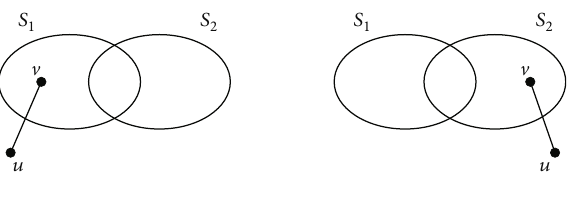
Figure 2: A distinguishable pair ð S